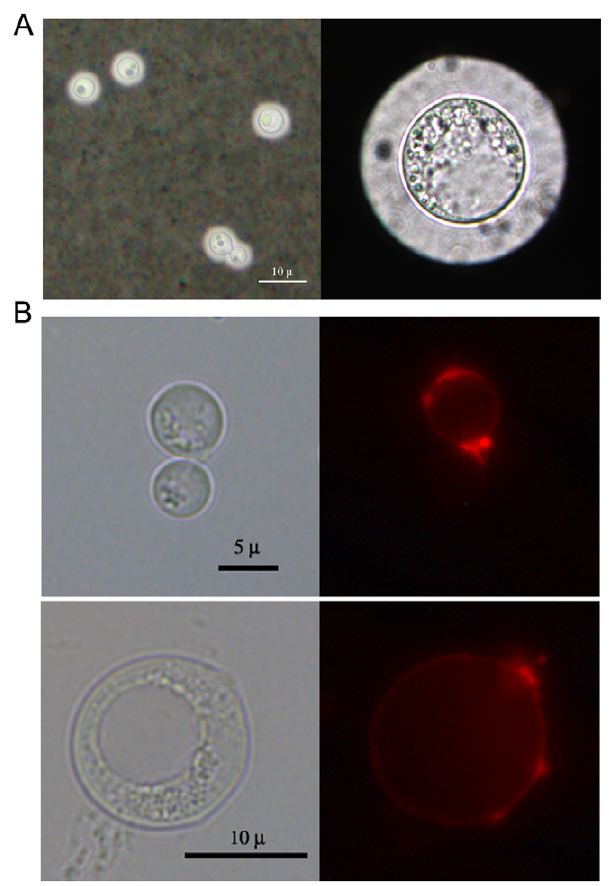
Figure 7. Cryptococcusneoformans forms giant cells in Galleria mellonella . A ) Figure shows photographs of C. neoformans cells suspended in India ink after overnight growth in Sabouraud broth and giant cells recovered from G. mellonella after 6 d of infection. Scale bar applies to both panels. B ) Binding of wheat germ agglutinin to C. neoformans as described in Material and Methods. Upper panels show cells grown in Sabouraud browth and lower panels show a representative cell recovered from caterpillars after 6 d of